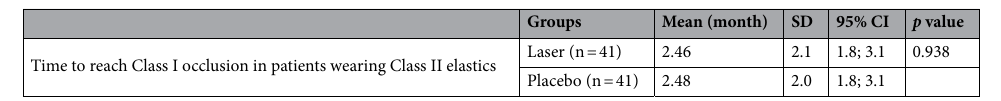
Table 2. Mean time to reach canine Class I occlusion in Class II elastics patients in the two groups. SD standard deviation, 95% CI 95% confidence interval; significant at p <